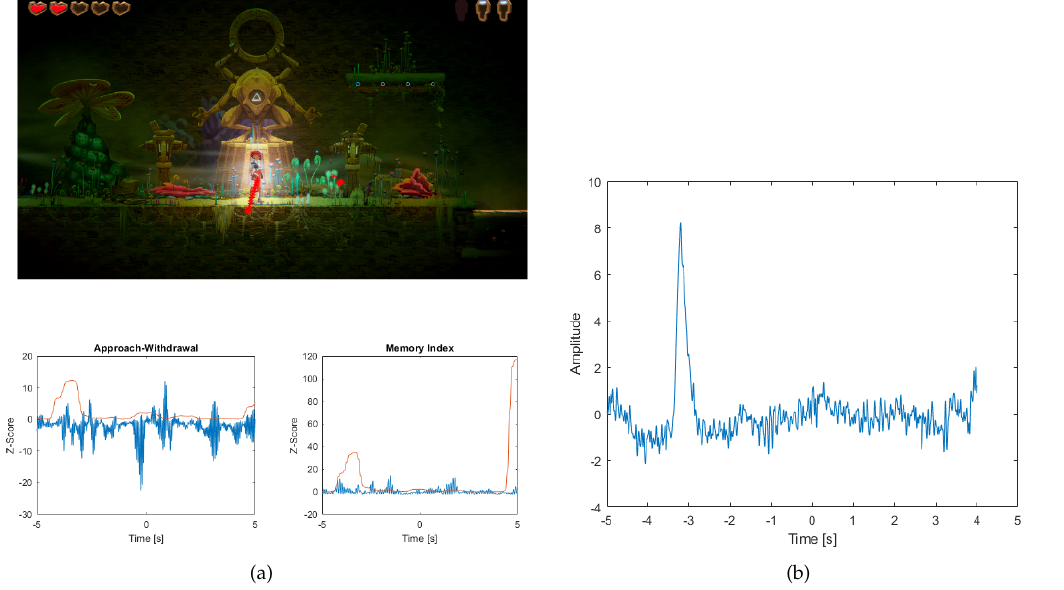
Figure 11. ( a ) The picture shows a screenshot of the game, where the hero revives at a fixed point after death. In the picture, the points where the player is looking are marked with red stars. Below are the graphs (blue) of the Approach-Withdrawal and Memory Index and the standard deviation value for both indices (red line) ( b ) A graph showing the occurrence of an ocular artifact before the hero’s rebirth